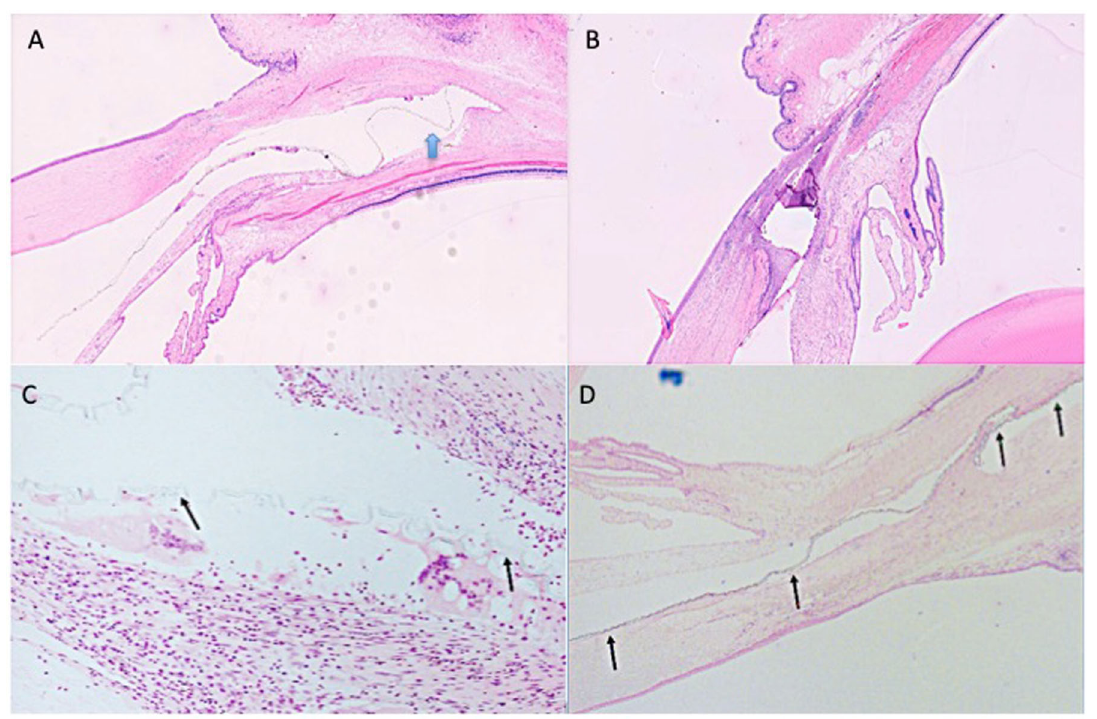
Fig. 5 VisiPlate histology. Placement of VisiPlate in the sub- conjunctival space showing minimal tissue response at 180 days OD ( A ) and OS ( B ). The implant was present, located within a con- junctival pocket and extending into the anterior chamber, close to, but not adhered to, the corneal endothelium. No in fl ammation or fi brosis was associated with the portion of the implant present in the anterior chamber. Within the pocket, the implant folded once upon itself in one small area. Chronic in fl ammation ( + 1), consisting of very small numbers of macrophages and foreign body giant cells, were associated